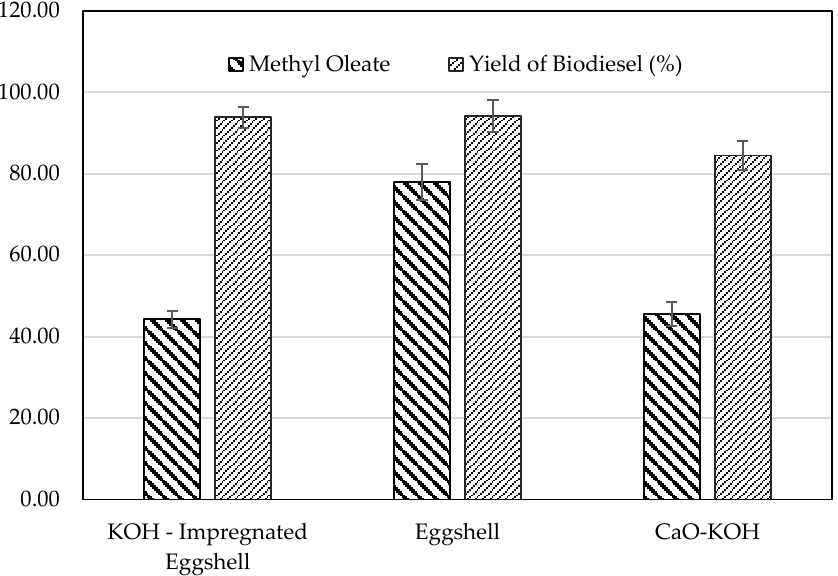
Figure 9. The yield of methyl ester produced by KOH-impregnated eggshell, eggshell, and CaO-KOH catalysts. The p -value of the ANOVA test was 0.000 ( p < 0.05) .